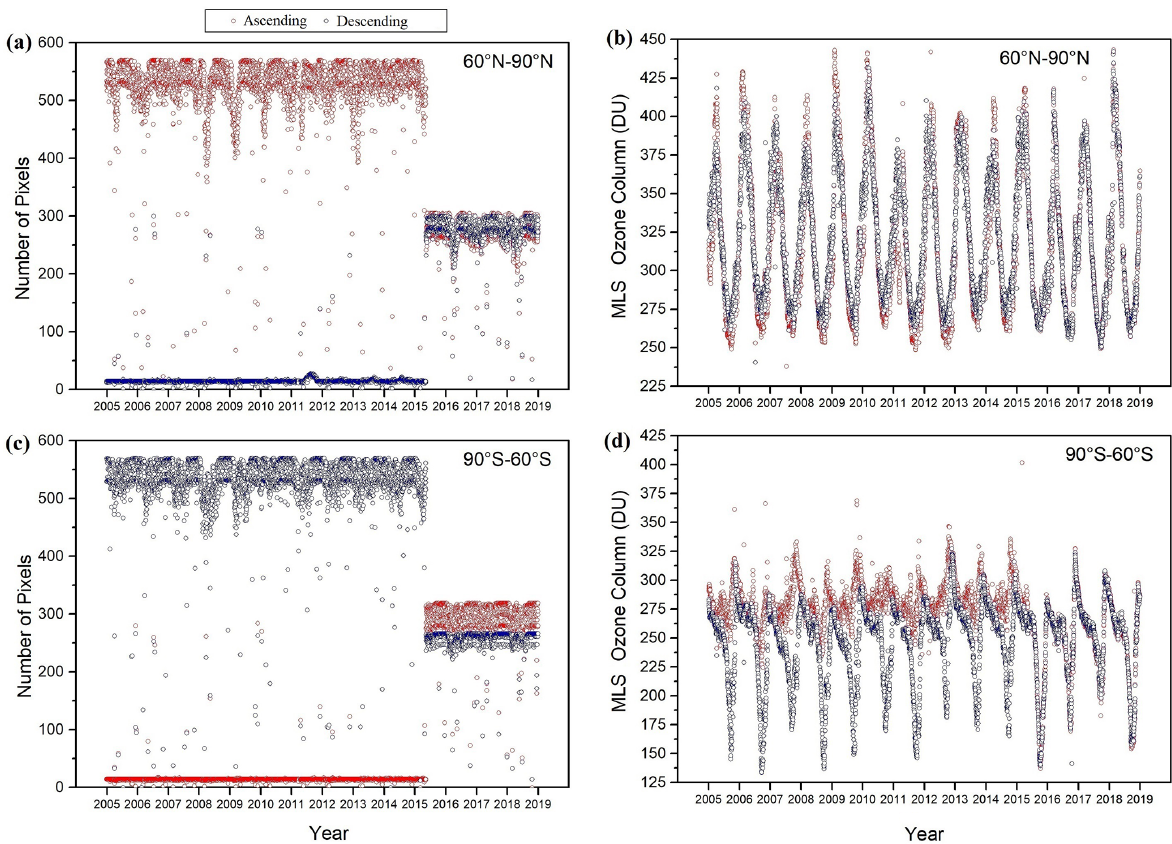
Figure 3. (a) Time series of daily number of ascending and descending pixels between 60 and 90 ◦ N. (b) Time series of daily average ascending and descending MLS SCO between 60 and 90 ◦ N. Panel (c) is the same as panel (a) but for 90–60 ◦ S. Panel (d) is the same as panel (b) but for 90–60 ◦